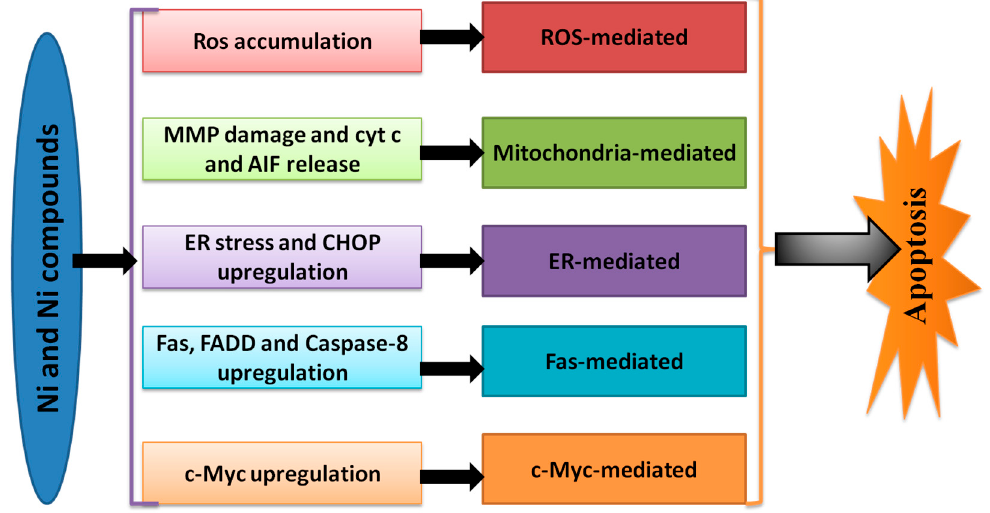
Figure 4. Pathways of Ni-induced apoptosis. The ROS-, mitochondria-, ER-, Fas- and c-Myc-mediated apoptotic pathway are all involved in Ni-induced cell